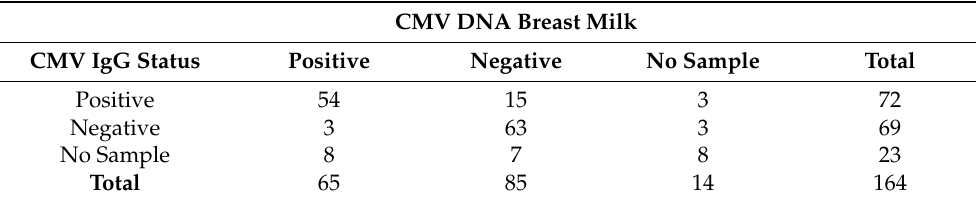
Table 4. Association of serostatus (infant sera used to infer maternal seroprevalence) and DNAlactia (maternal breast milk samples). Serostatus was inferred by assay of infant IgG using the first sample available on the newborn infant, and this was compared to the presence of CMV DNAlactia measured by PCR in the corresponding breast milk